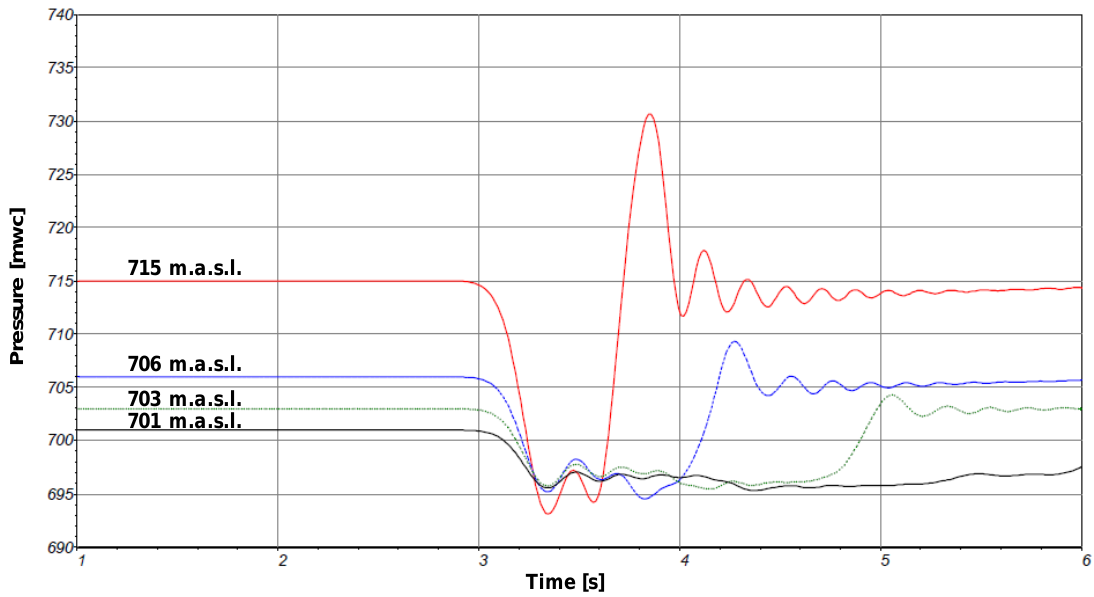
Figure 8. Penstock piezometric head evolution (upper zone) after a wind generator trip for different upper reservoir levels after a 2.3 MW wind generator trip.